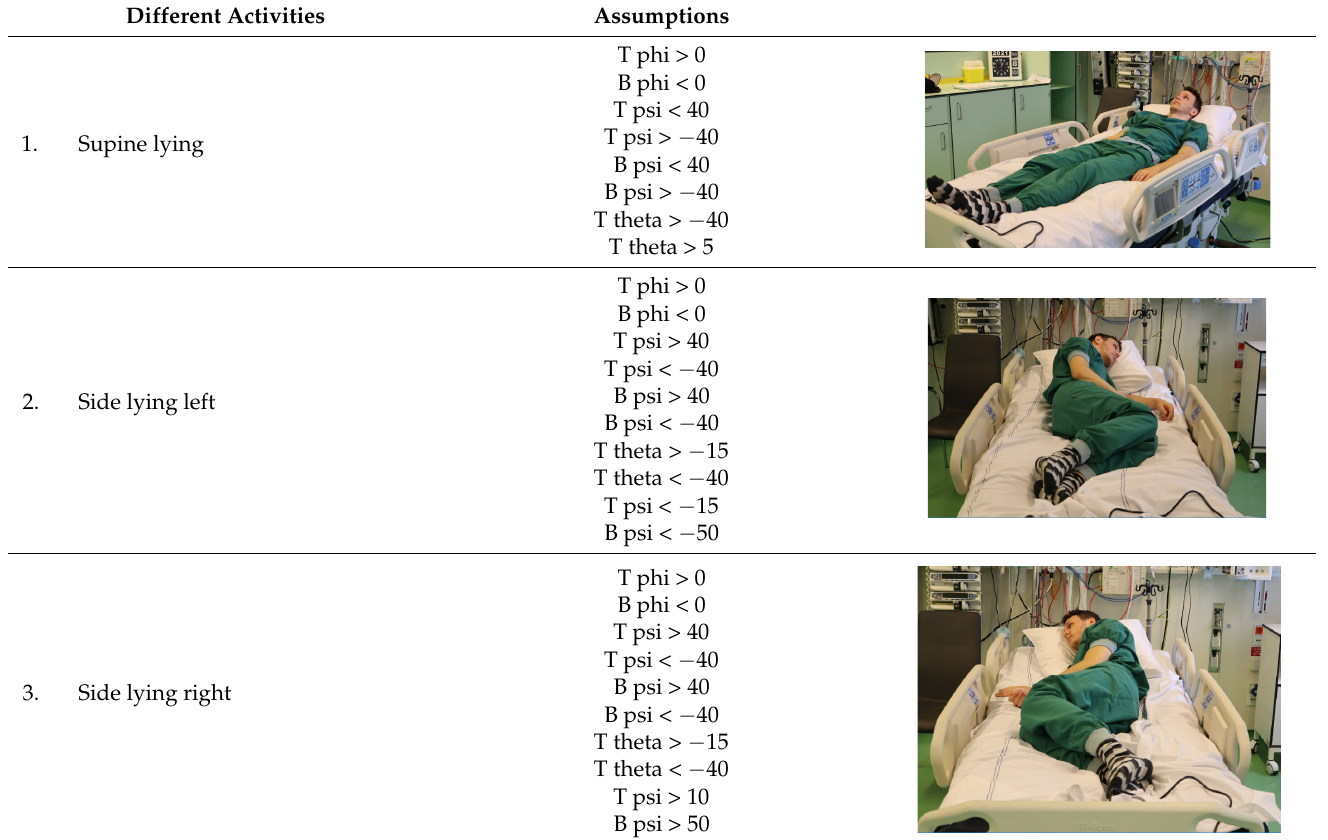
Table A2. Classification of Activities Based on Body-Segment-Angles and SMA Values from Two Three-Axis Accelerometers (Placed on Thorax and Opposite Leg).